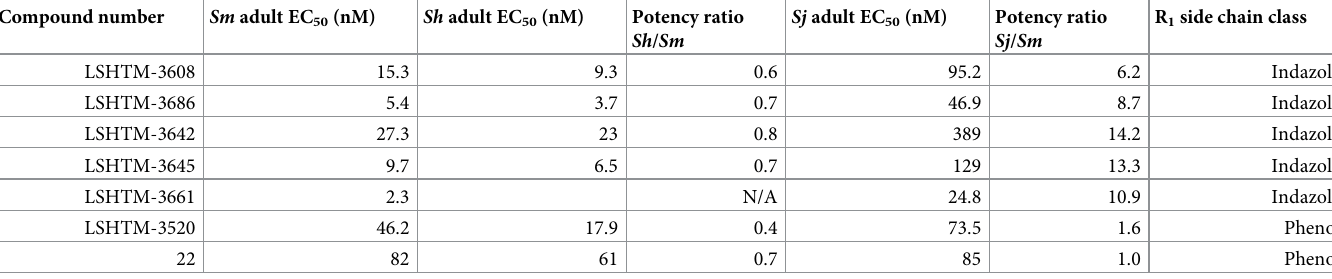
Table 3. SAR table showing potency of compounds against different clinically relevant Schistosoma species in vitro . Compound